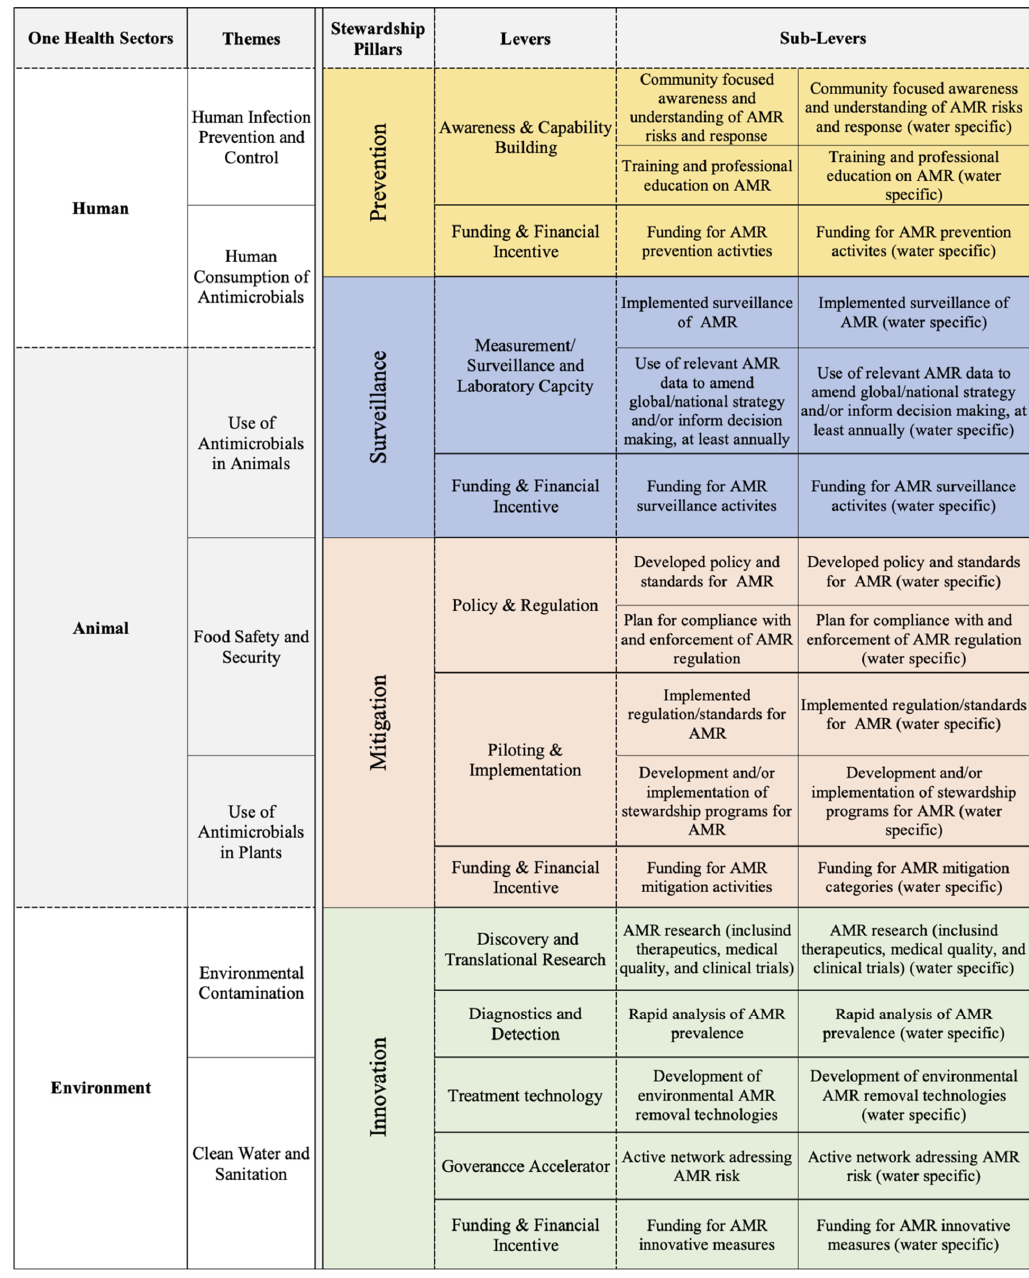
Figure 11. The One Health-One Water AMR stewardship framework.